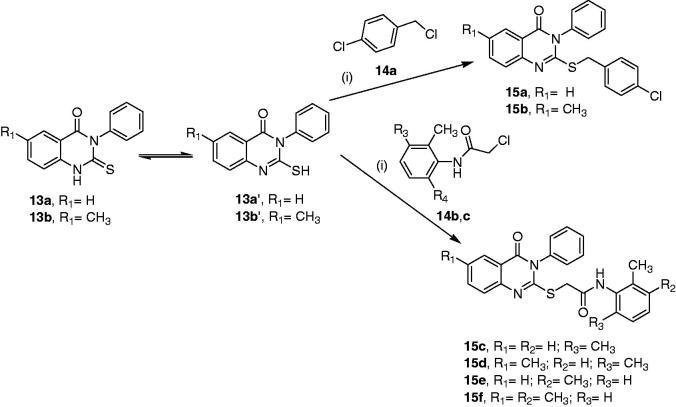
Reagents and conditions: (i) K2CO3 and dry acetone, reflux for 6–8 h.